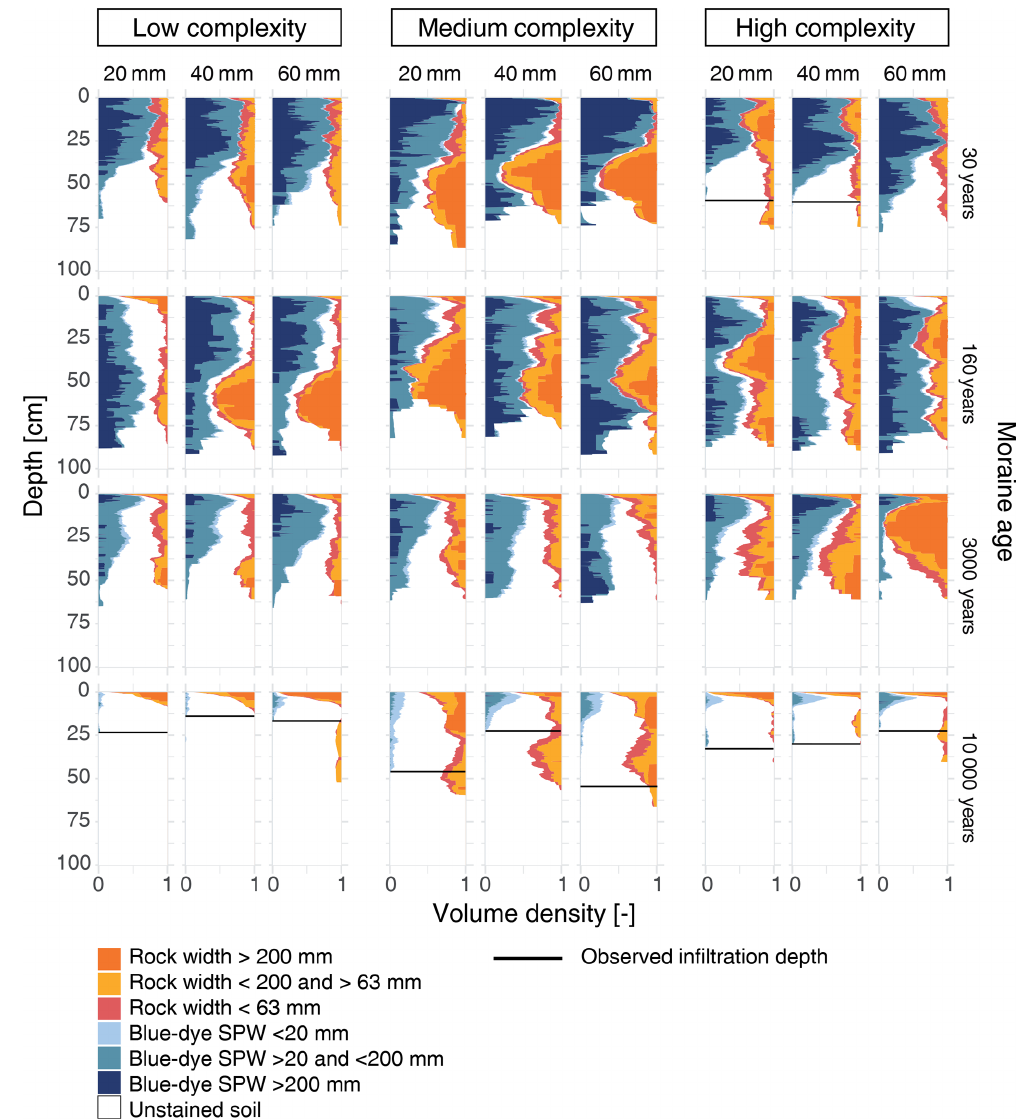
Figure 7. Volume density profiles per age class, vegetation complexity, and irrigation amount. The volume density is the fraction of stained pixels, here colored by flow path width (stained path width; SPW) and rock